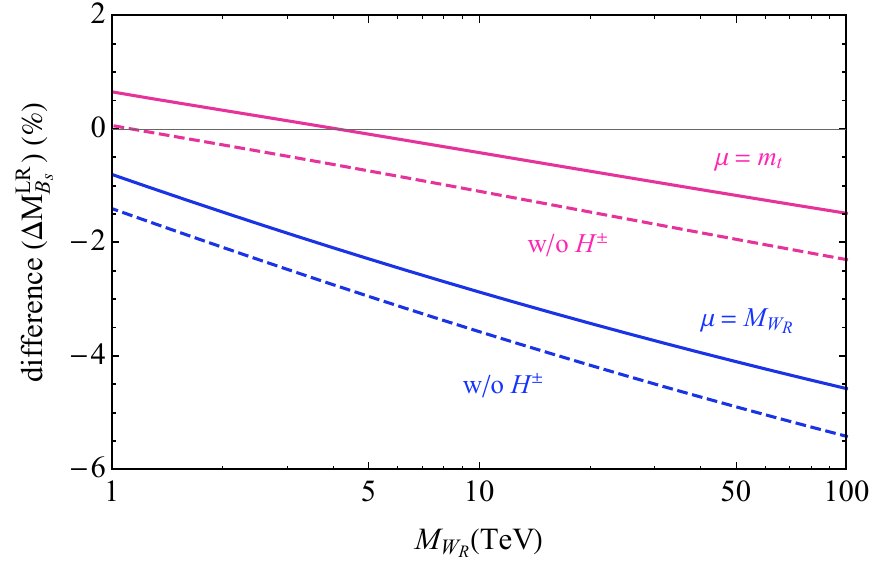
Figure 4 . (cid:1) M B in comparison with the conventional results at (cid:22) = M W s genta). The dashed lines do not include the contribution from the heavy charged Higgs boson. are applied for B -parameters. We also use the RunDec program [37] for evaluating